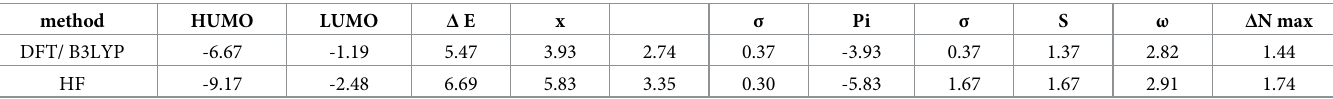
Table 4. Quantum chemical parameters for methyl 4-hydroxybenzoate calculated at the HF and DFT levels. method HUMO LUMO Δ E x σ Pi σ S ω Δ N max DFT/ B3LYP -6.67 -1.19 HF